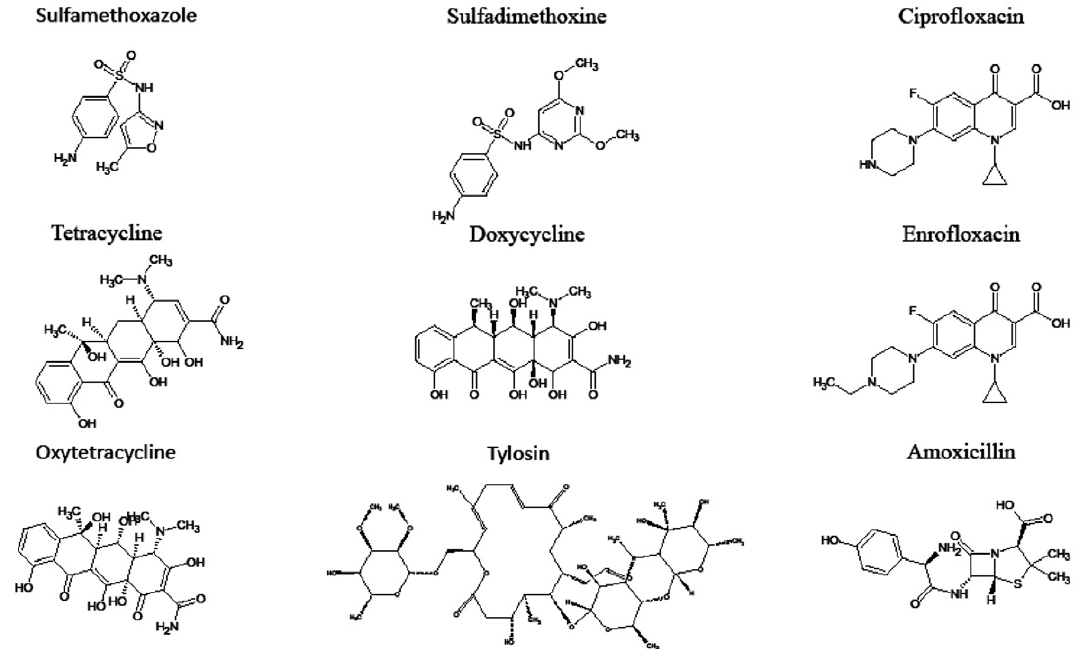
Figure 1. Assayed antibiotic molecules: sulfamethoxazole (SMX), sulfadimethoxine (SDX), ciprofloxacin (CIP), tetracycline (TETRA), doxycycline (DOX), enrofloxacin (ENRO), oxytetracycline (OXI), tylosin (TYL), and amoxicillin (AMOXI). Structures developed using ACD/Labs ChemSketch ®